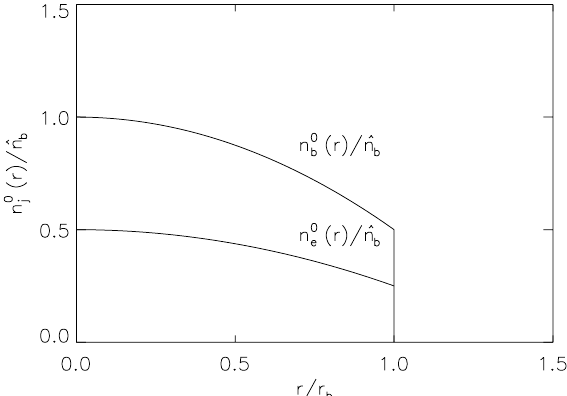
FIG. 4. Plots versus normalized radius (cid:114) (cid:121) (cid:114) (cid:98) of the equilib- rium ion density profile (cid:110) (cid:48) (cid:98) (cid:115) (cid:114) (cid:100) defined in Eq. (60) and the electron density profile (cid:110) (cid:48) illustration, we have taken e (cid:173) (cid:48)(cid:46)(cid:53) , (cid:102) (cid:173) (cid:48)(cid:46)(cid:53) , and (cid:90) (cid:98) (cid:173) (cid:49) in the